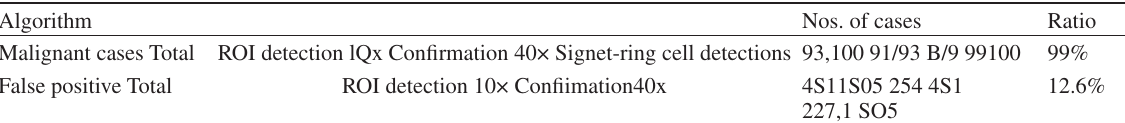
Detection ratios of the tissue samples as malignant